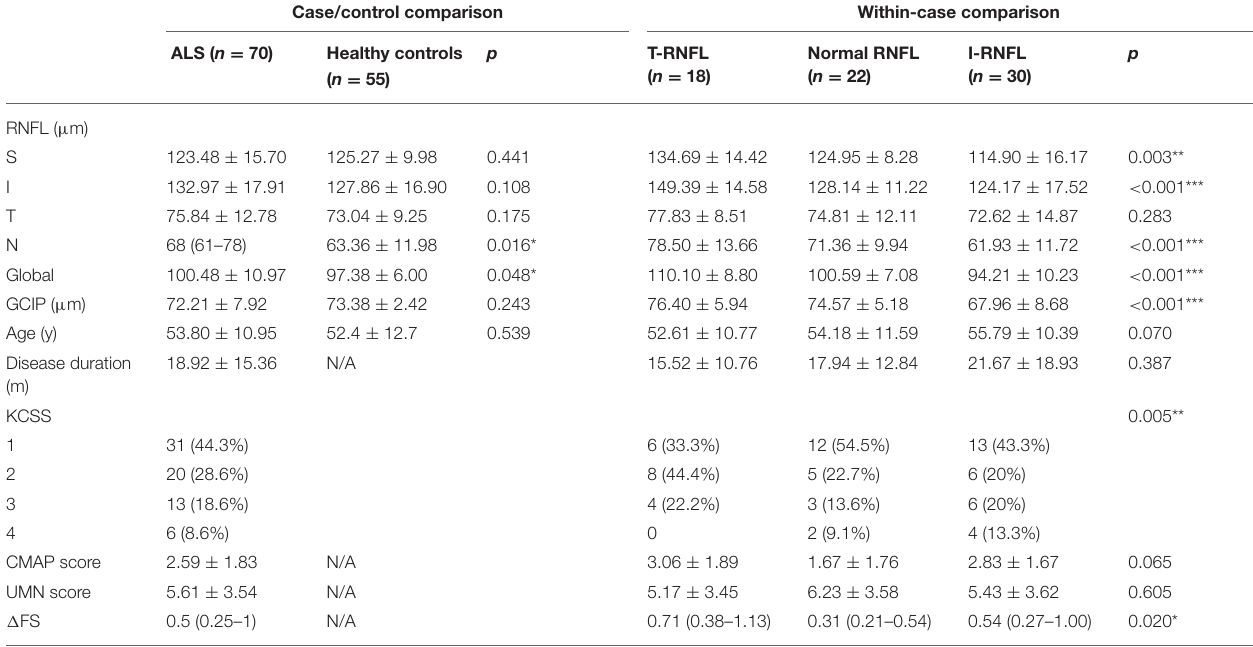
TABLE 2 | Comparison of the OCT results and ALS disease parameters among the groups. Case/control comparison